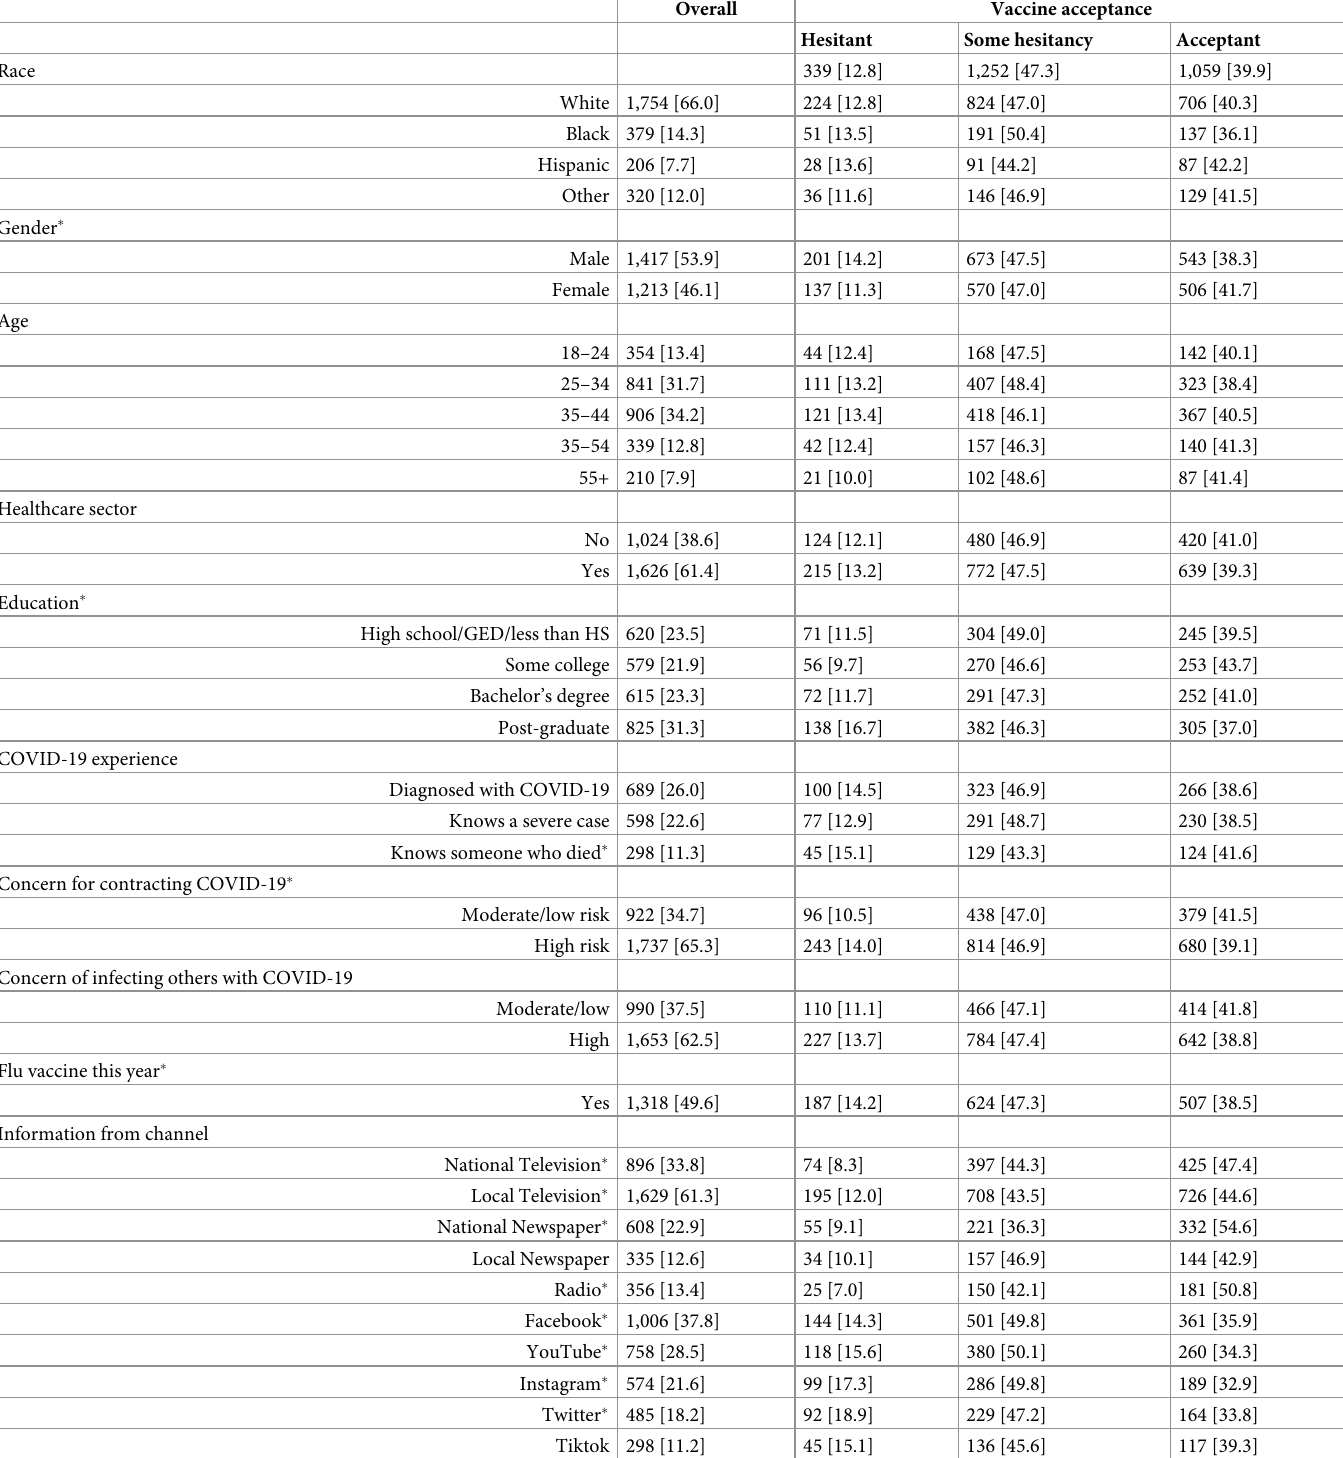
Table 2. Univariate and bivariate